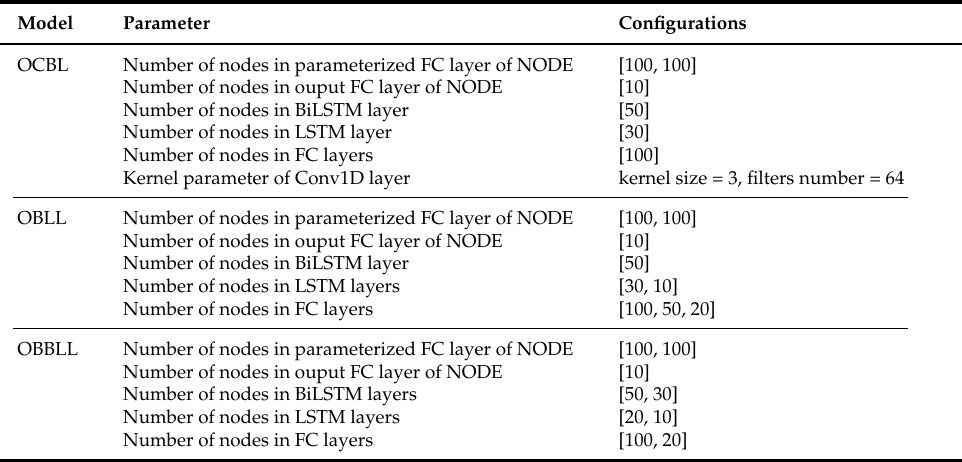
Table 1. Parameter setting of the proposed